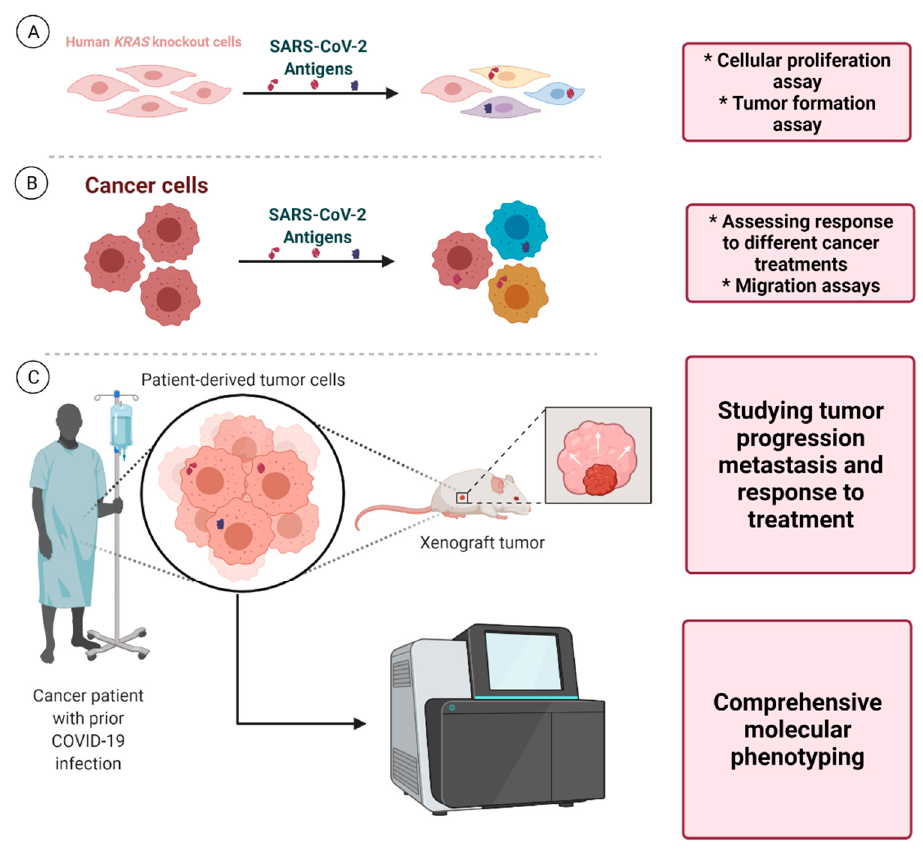
Figure 4. Proposed framework for laboratory-based investigations. ( A ) Investigations that could unravel the potential effects of various SARS-CoV-2 antigens on cellular proliferation and tumor formation in human KRAS knockout cells. ( B ) Using patient-derived cancer cells, the effect of these antigens and the subsequent autophagy blockade and MHC-I downregulation on response to different cancer treatments and metastasis (migration assays) could be studied. ( C ) Furthermore, studying tumor specimens arising in the presence of SARS-CoV-2 antigens using xenograft mouse models and also advanced molecular phenotyping techniques could unravel tumor biological behavior (growth rate, metastasis, etc.), its molecular characteristics, and the underlying factors affecting its response to various cancer